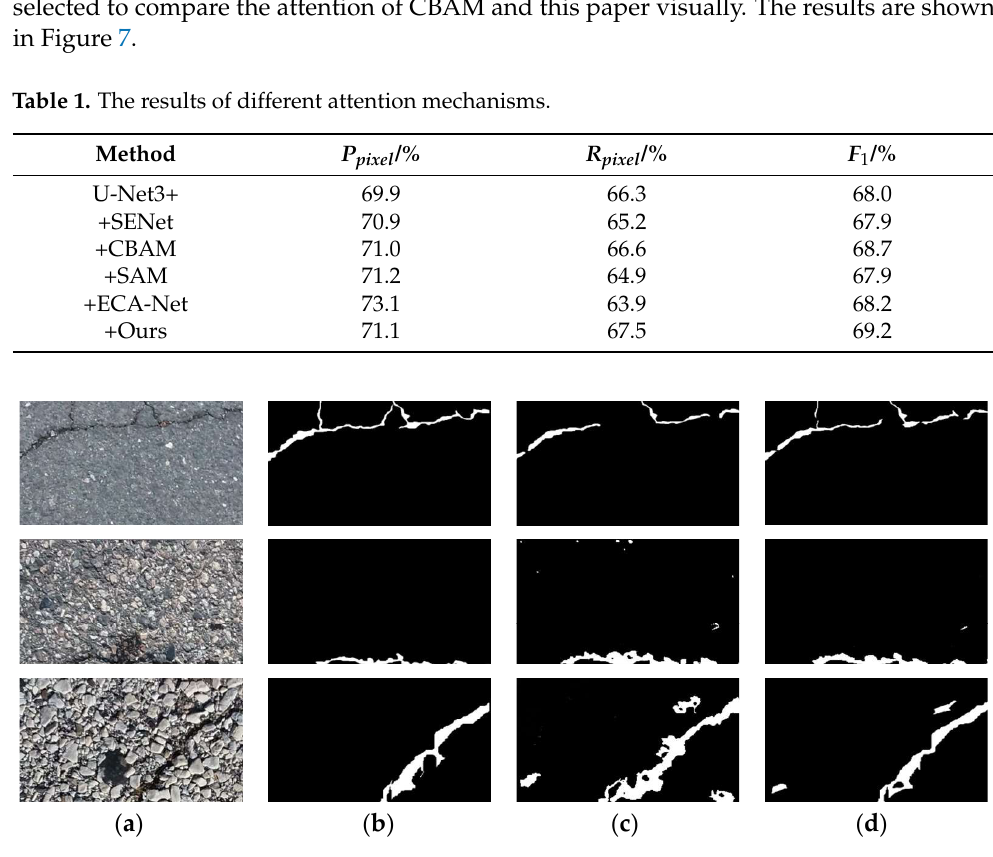
Figure 7. Visualization results of different attention mechanisms. ( a ) Road Image; ( b ) Ground Truth; ( c ) CBAM; ( d ) Ours. ( c ) CBAM; ( d )